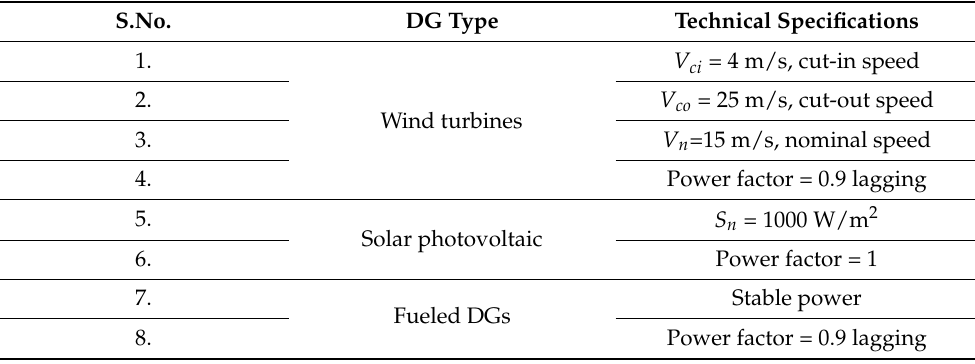
Table 4. Data for wind and solar-based DG for different scenarios.